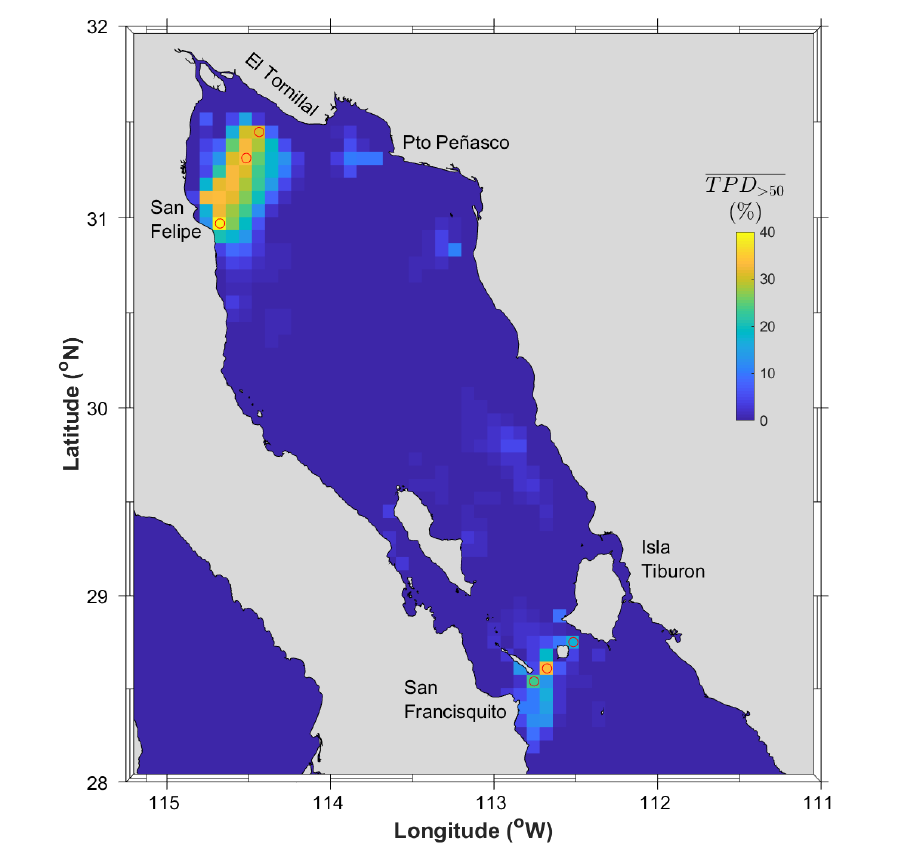
Figure 6. Map of percentage time % T when TPD > 50 W m − 2 . The red circles correspond to the six most energetic locations, defined in the